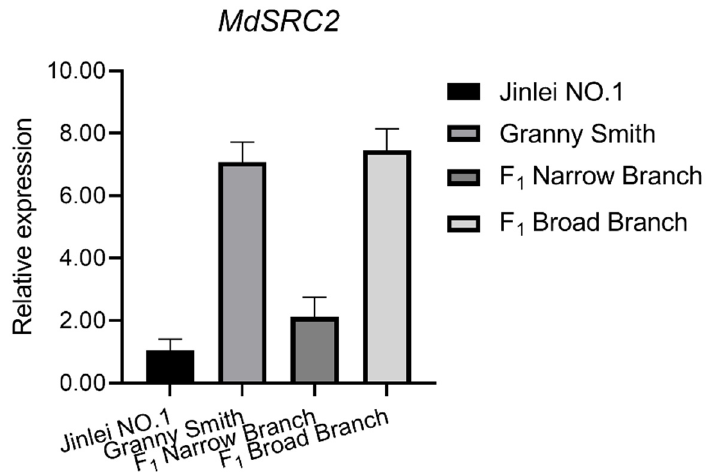
Figure 10. Expression of MdSRC2 in parental cultivars and F 1 progeny.